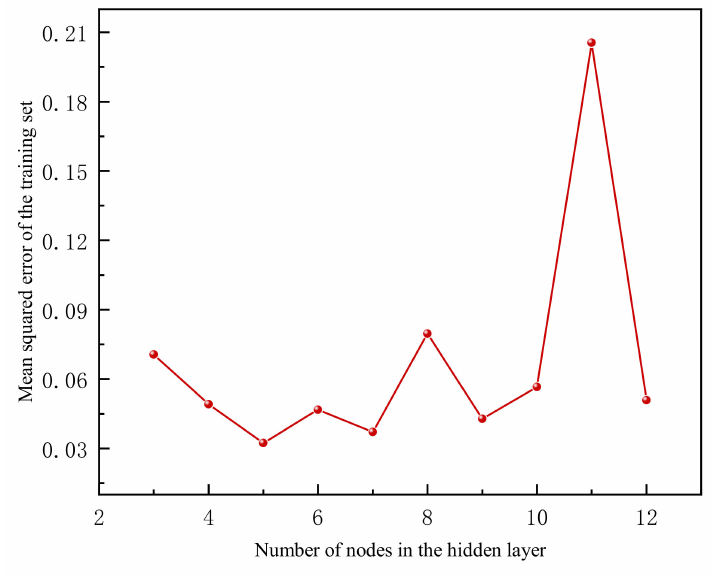
Figure 6. MSE of different number of hidden layer nodes for SSA-BPNN model.